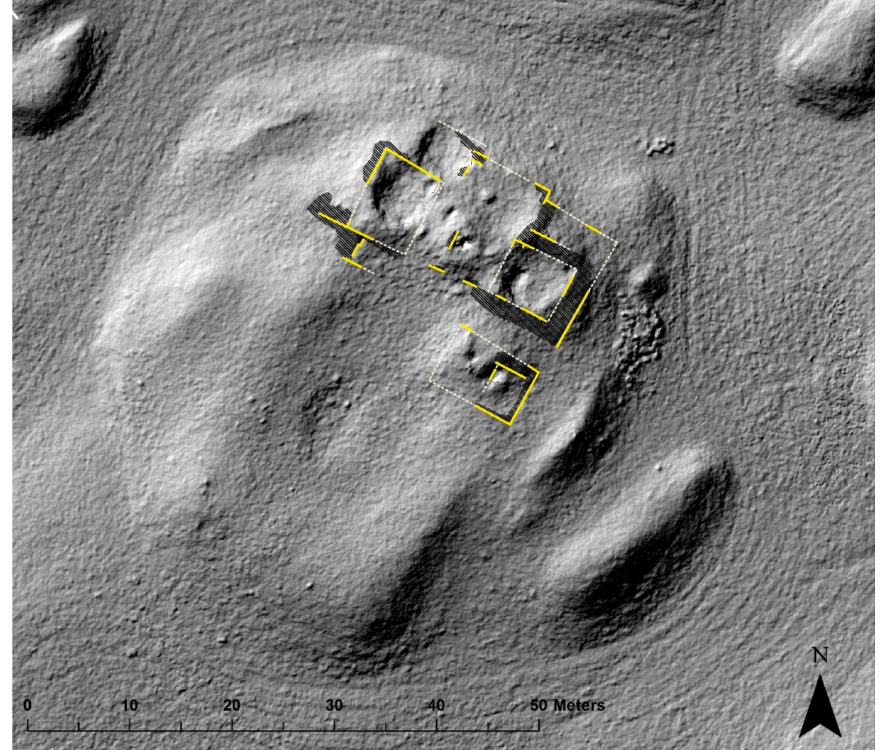
Figure 11. Kona Makhm¯ur, locus (interpreted as a church) with remains of masonry exposed on the surface. The digital surface model, exported from the UAV DEM output, was used as the base. The combination of field prospection and remote sensing data provides a unique opportunity to complete the detailed plan (authors: Karel Nov á ˇcek and Lenka Starkov á